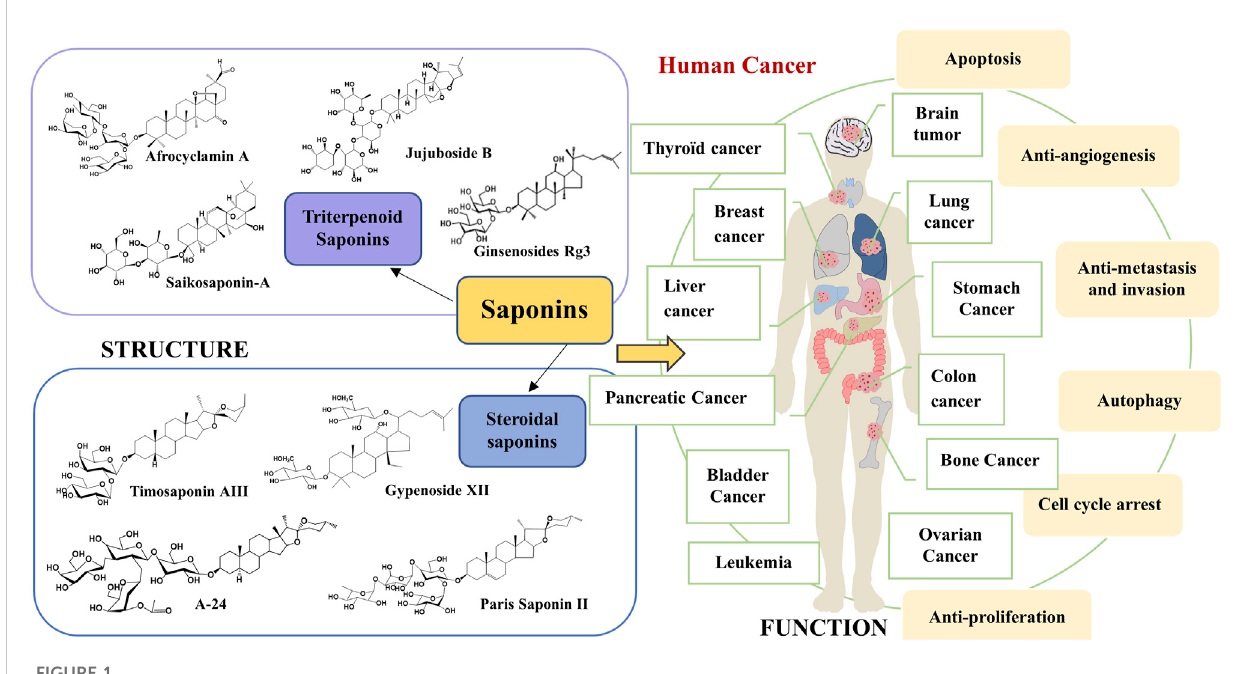
FIGURE 1 The therapeutic mechanism of saponins from Chinese herbal medicine on